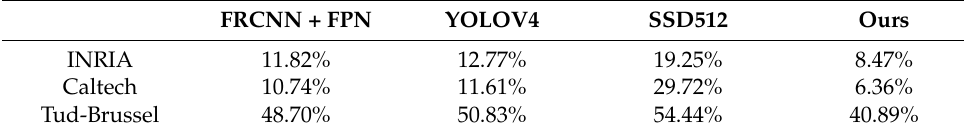
Table 4. Comparison with state-of-the-art methods on Different Datasets.